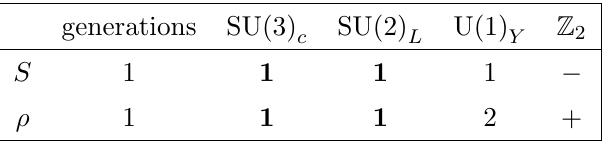
Table 5 . New particles in the cocktail model with respect to the